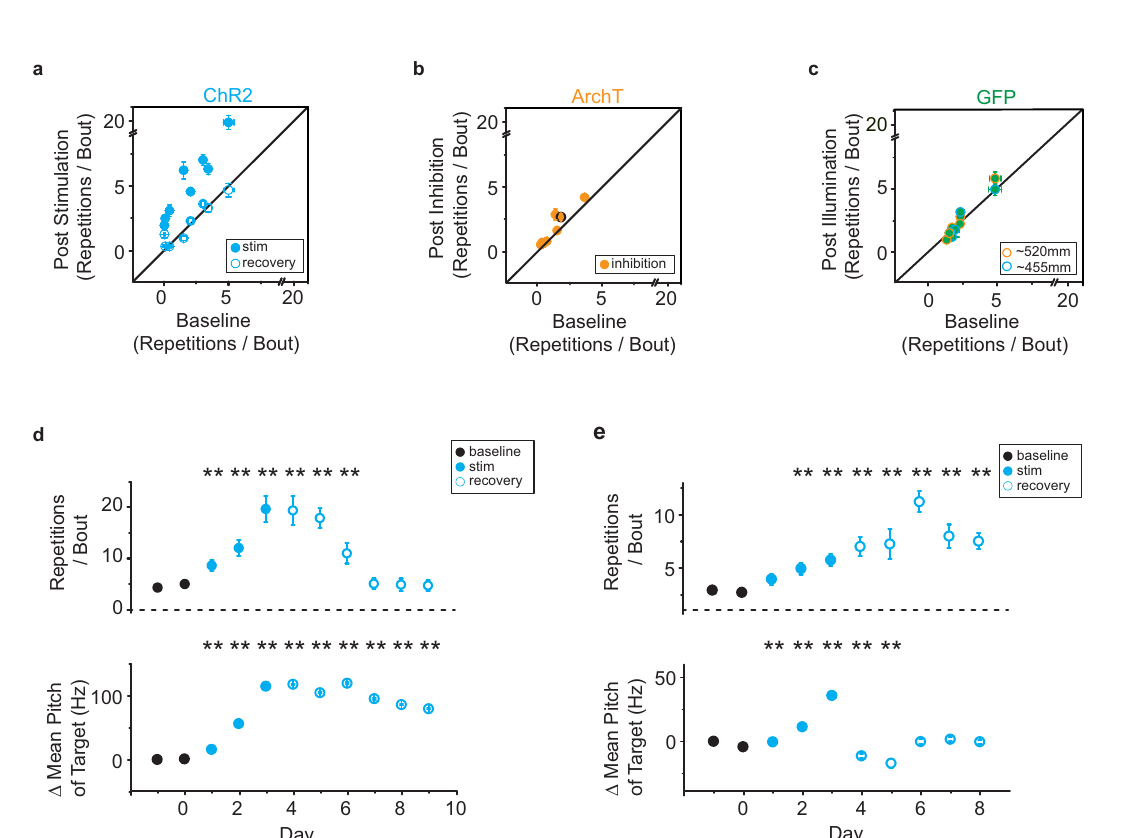
Fig. 8 Optical stimulation causes vocal repetitions independent of changes in pitch. a Comparison of the number of repetitions of vocal element per song bout (mean ± SEM) for the baseline day versus last stimulation day in 6 ChR2 + birds ( fi lled, p < 0.0001, Kruskal – Wallis test) or last recovery day (open, p > 0.35, Kruskal – Wallis test, n = 8 vocal elements). The number of repetitions of vocal elements on the last stimulation day was signi fi cantly higher than the number of repetitions on either the baseline day or the last recovery day ( p = 0.0081, Friedman test), with no signi fi cant difference between the baseline day and the last recovery day ( p > 0.99, Friedman test). b Comparison of the number of repetitions of vocal element per song bout (mean ± SEM) on the baseline day versus last inhibition day in 6 ArchT + birds (5 fi lled circles, p > 0.08; 1 fi lled with black outline, p = 0.028, Kruskal – Wallis test, n = 8 syllables). c Same as b , but for GFP + birds (blue outline, p > 0.8, Kruskal – Wallis test, n = 6 syllables from 3 birds; orange outline, p > 0.15, Kruskal – Wallis test, n = 7 syllables from 3 birds). Blue and orange outlines indicate birds illuminated by LED with wavelength of ~455 nm or 520 nm, respectively. d The number of syllable repetitions per song bout (top, mean ± 95% con fi dence interval[CI]) for the bird shown in Fig. 7f and changes of the mean pitch of the optically targeted syllable(bottom, mean ± 95% CI)(blue line in Fig. 7f) during baseline (black circles, days − 1 and 0), stimulation ( fi lled blue circles, days 1 – 3), and recovery (open blue circles, days 4 – 9). The number of repetitions of the affected syllable (red line in Fig. 7f) per song bout was signi fi cantly increased during days 1 – 6 relative to baseline ( p < 0.01, Kruskal – Wallis test), whereas changes in the mean pitch of the target syllable during days 1 – 9 were signi fi cantly higher than changes at baseline ( p < 0.01, Kruskal – Wallis test). e same as d , but for another bird. The number of repetitions of the affected syllable per song bout was signi fi cantly increased during days 2 – 8 relative to baseline ( p < 0.01, Kruskal – Wallis test), whereas changes in the mean pitch of the target syllable during days 1 – 5 were signi fi cantly higher than changes at baseline ( p < 0.01, Kruskal – Wallis